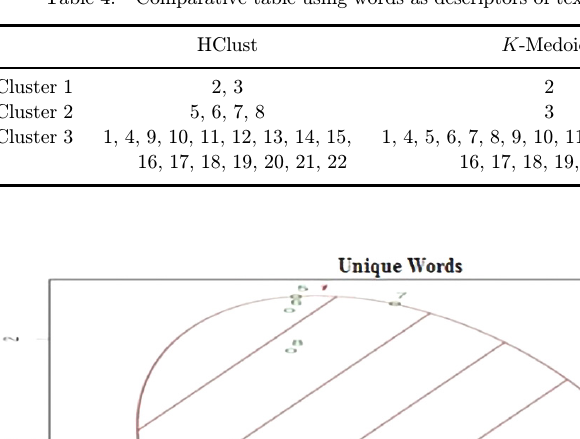
Table 4. Comparative table using words as descriptors of textual data.